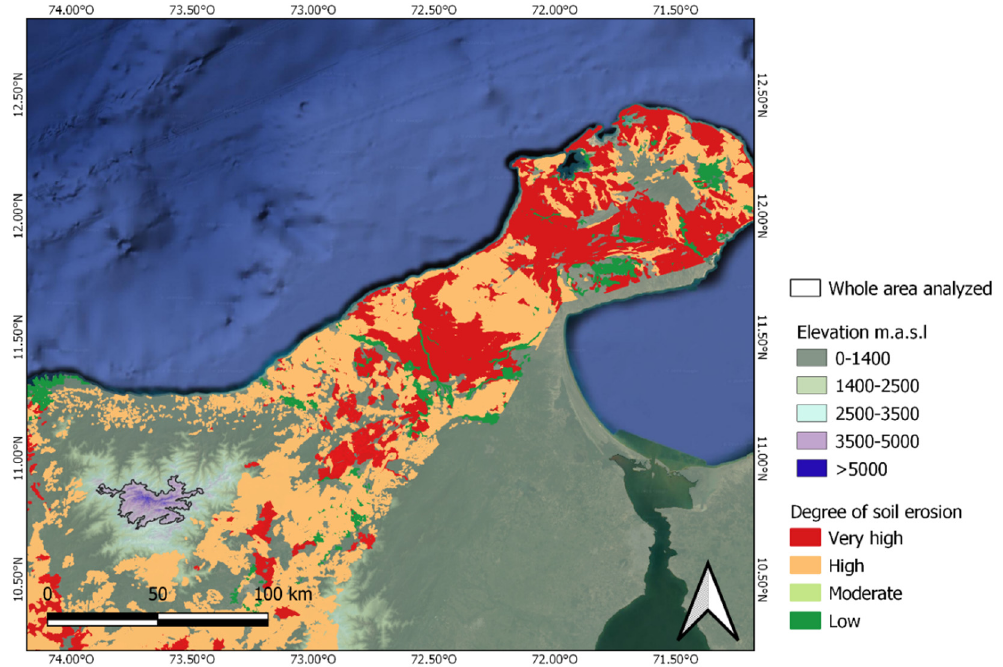
Figure 6. Degree of soil erosion in the surroundings of the SNSM (2010–2011) [93]. Each degree has been established according to the level of degradation of the A horizon soil layer. The A horizon is known as the top layer of the mineral soil horizons, often referred to as topsoil. This layer is important because it contains dark decomposed organic matter (humus). Then, this figure represents the degree of soil erosion by total loss of the A horizon (very high), loss greater than 75% of the A horizon (high), loss between 25% and 75% of the A horizon (moderate), and loss of less than 25% of the A horizon (low) [96]. (For interpretation of the references to color in this figure legend, the reader is referred to the web version of this